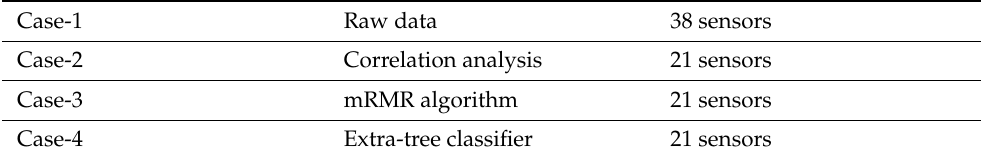
Table 4. Case scenarios for the machine-learning